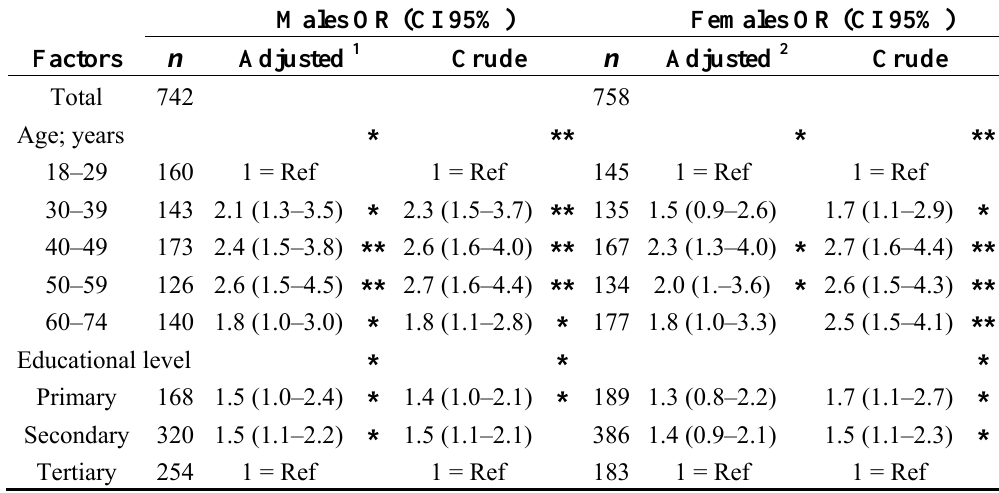
Table 5. Logistic regression analysis of factors affecting CN after median split (low CN: 0–7, high CN: 8–10), stratified by